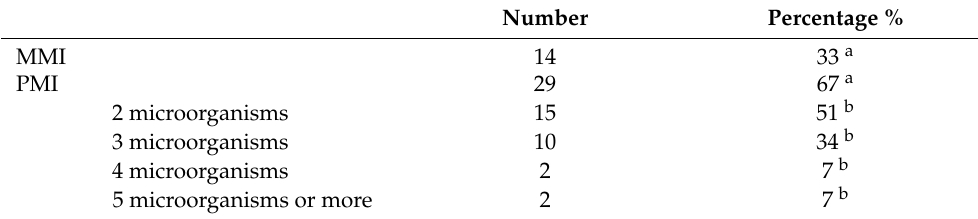
Table 6. Polymicrobial and Mono-microbial